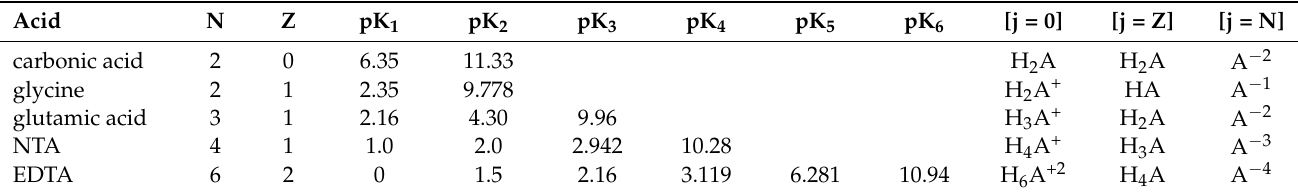
Table 12. Acidity constants for carbonic acid and zwitterionic acids (the pK values for EDTA are taken from [5]; they differ slightly from those in [17]).